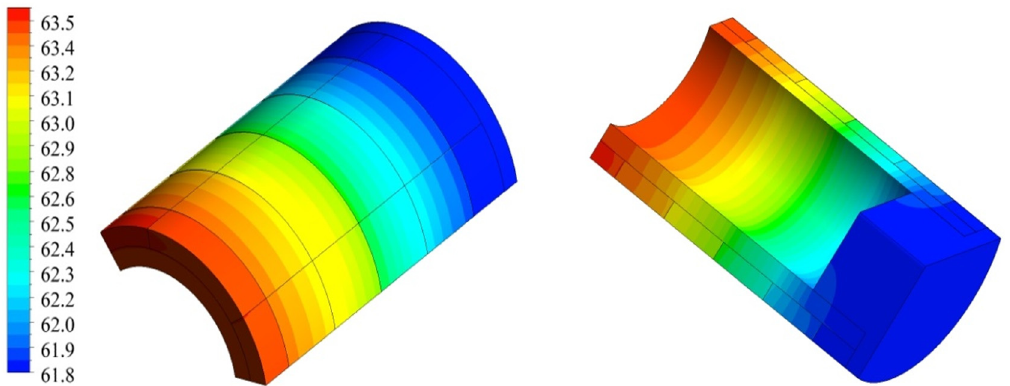
Figure 15. Temperature field distribution of the PMs and mover yoke (in